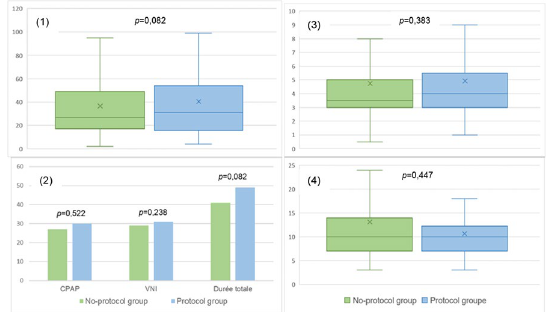
Fig. 1 No‑protocol and protocol groups comparison: CPAP duration (1), ventilatory support duration (2), PICU LOS (3), hospital LOS